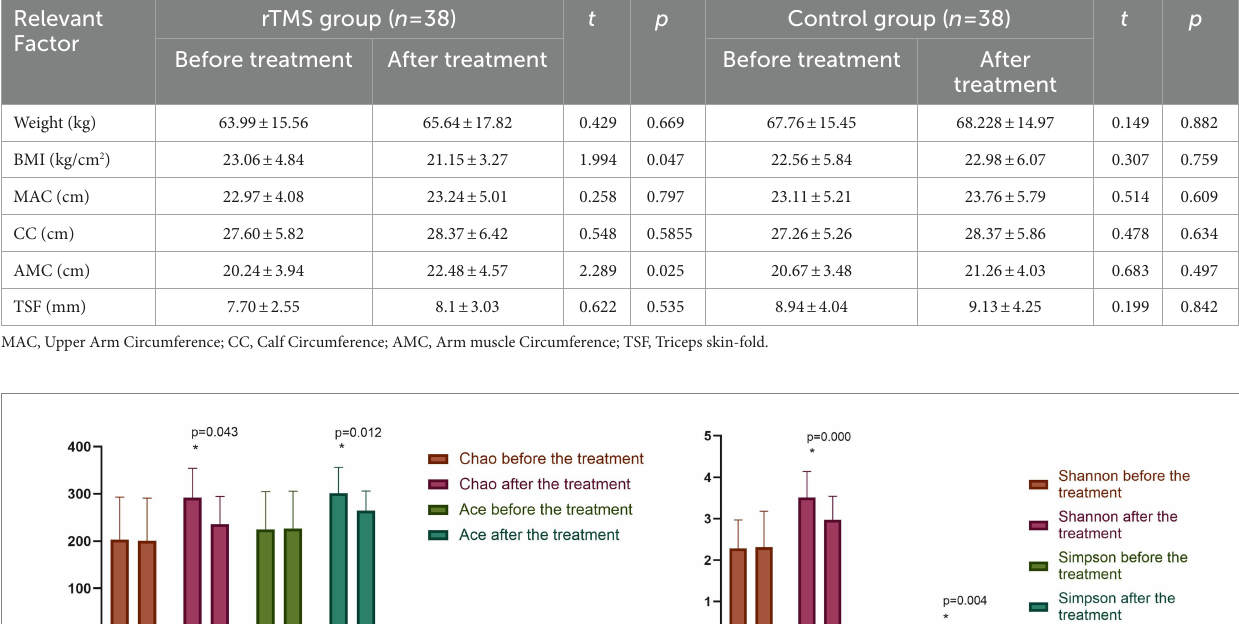
TABLE 5 The variations at the time-points.